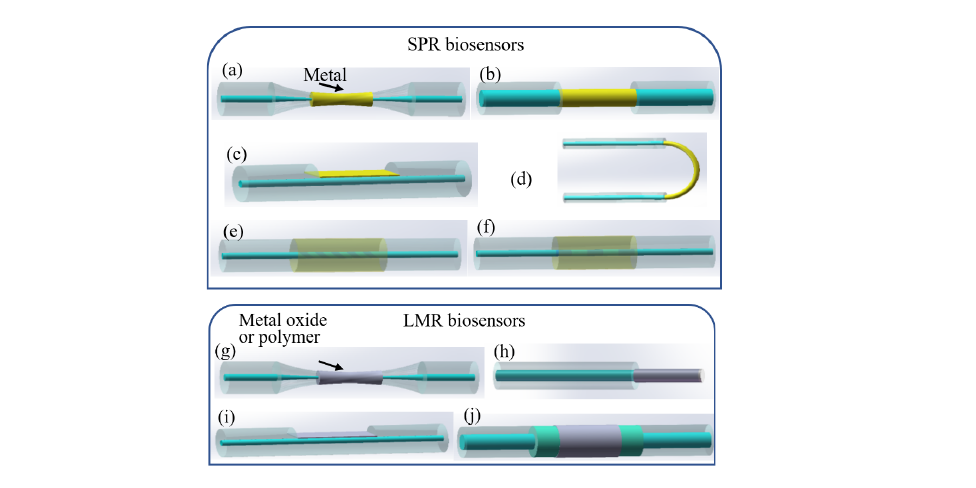
Figure 4. The schematic diagrams of SPR biosensors based on ( a ) MF, ( b ) unclad fiber, ( c ) D-shaped fiber, ( d ) U-bent fiber, ( e ) tilted fiber Bragg grating, and ( f ) long period grating and LMR biosensors based on ( g ) MF, ( h ) reflective unclad MMF, ( i ) D-shaped fiber, and ( j ) multimode-coreless-multimode (MCM) fiber structure.